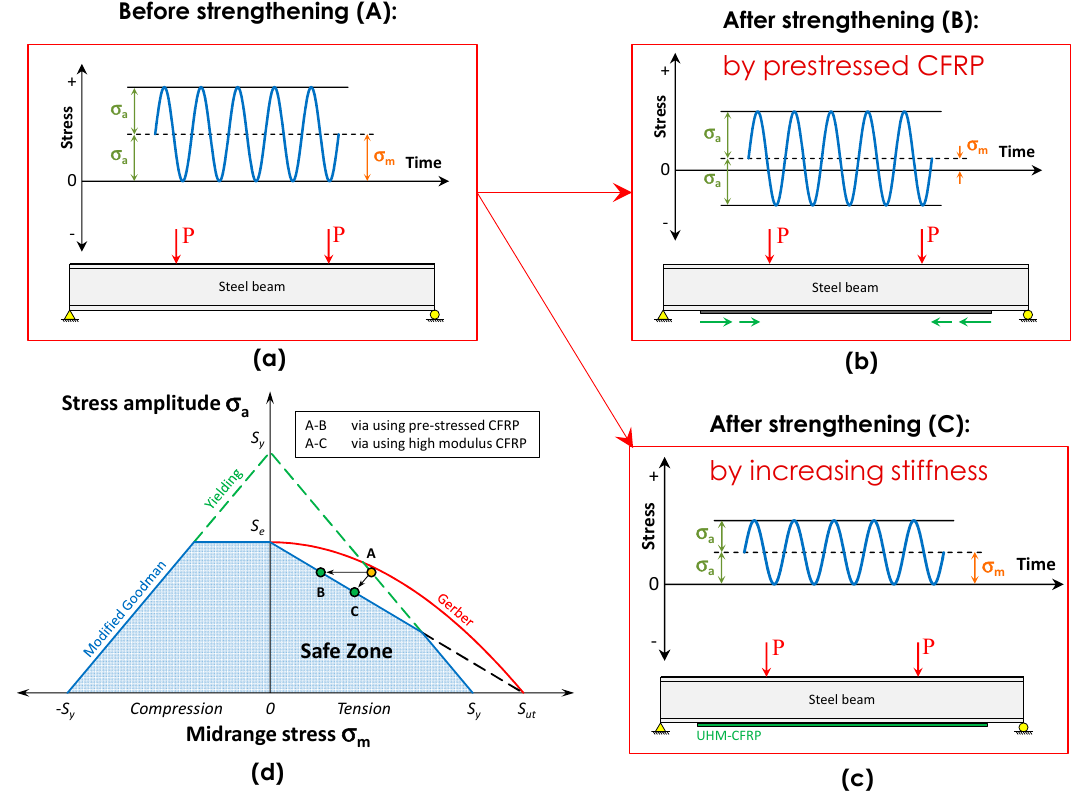
Figure 4. The stress at the bottom flange of a beam subjected to external cyclic loading, P, when the beam is ( a ) not strengthened; ( b ) strengthened with the pre-stressed NM CFRP plate or ( c ) strengthened with the ultra-high modulus (UHM) plates; ( d ) A CLD that indicates the stresses prior to and after strengthening.